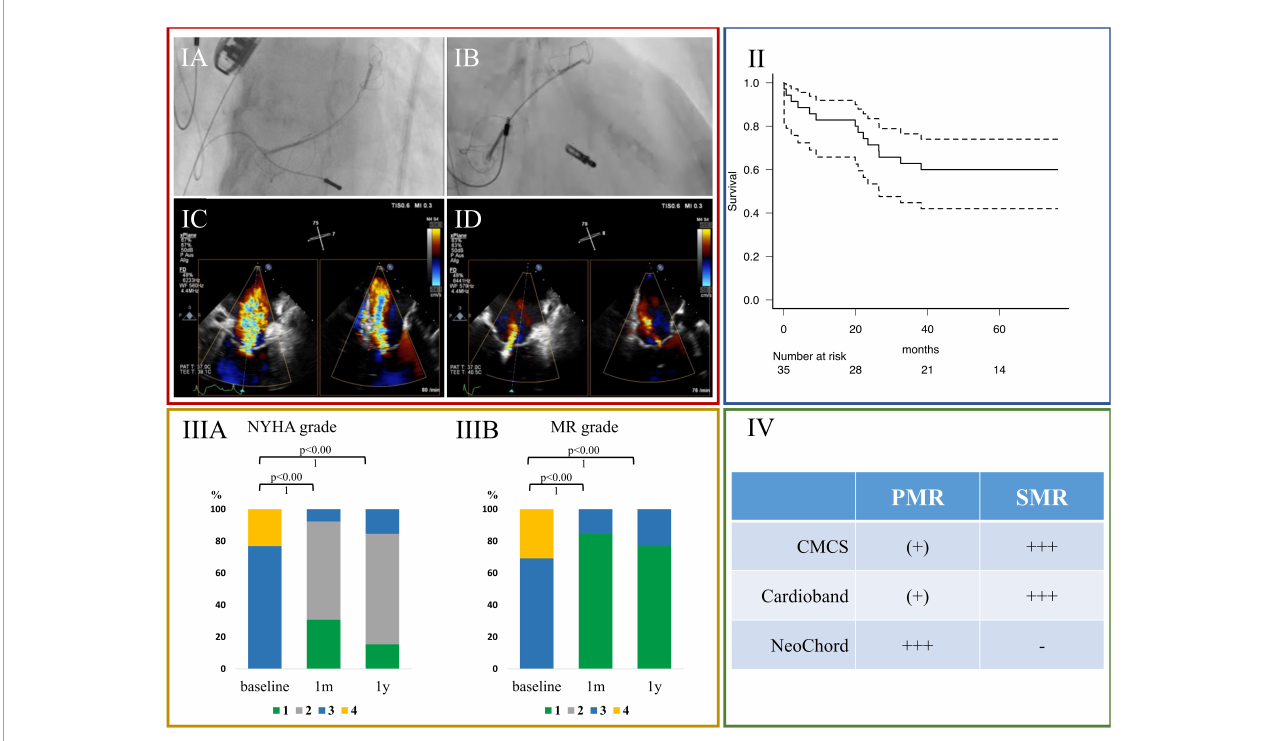
FIGURE2 (IA–ID) : A representative case of severe SMR treated with M-TEER and CMCS. (IA,IB) Fluoroscopic images. (IA) At first CMCS was inserted into coronary sinus, followed by M-TEER (IB) . (IC,ID) Transesophageal echocardiographic images during procedure. (IC) Before CMCS was inserted. (ID) After both CMCS and M-TEER were implanted. The change of MR severity was from severe to mild. (II) Kaplan Meyer curve of all-cause death of all patients treated with COMBO-TMVr ( n = 35). (IIIA) Serial New York Heart Association functional class, and (IIIB) serial severity of mitral regurgitation. (IV) Favorable ranges of use for different devices: (-); not applicable, [(+)]; useable, (+++) favorable use. CMCS, Carillon Mitral Contour System; LVEF, left ventricular ejection fraction; LVESV, left ventricular end-systolic volume; LVEDV, left ventricular end-diastolic volume; LV mass, left ventricular mass; LAVi, left atrial